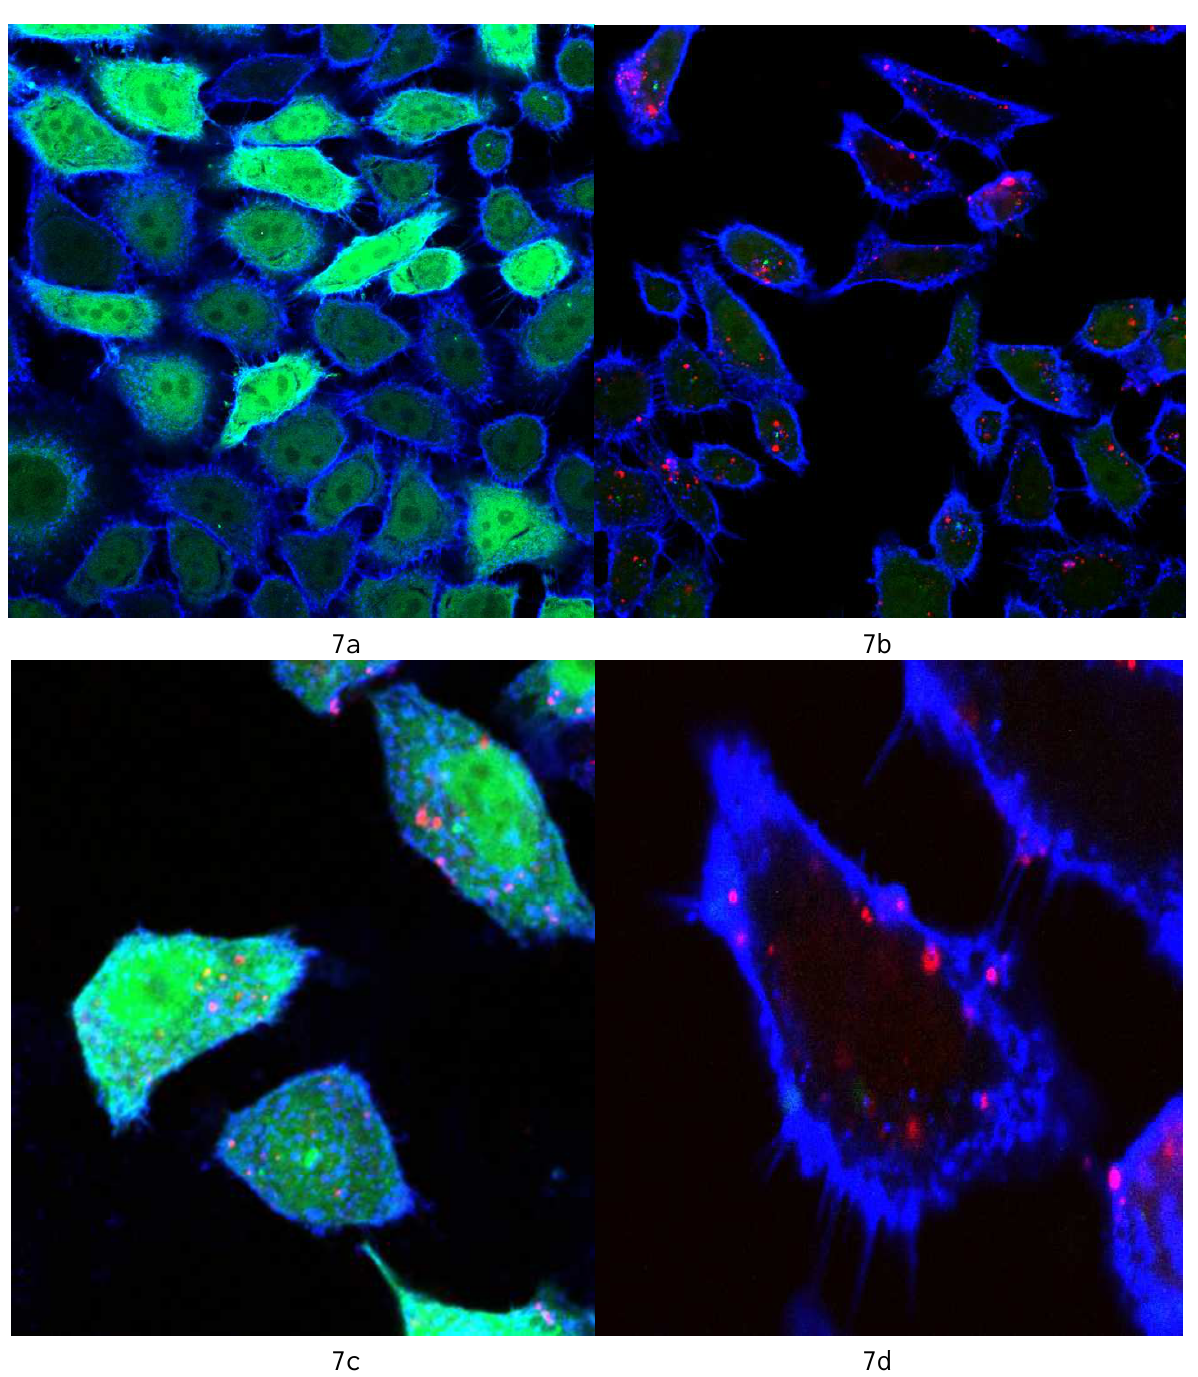
Figure 7. Confocal microscopy cell imaging. GFP fluorescence (green), cell membrane stained with WGA-Alexa Fluor ® 555 (blue), and Alexa Fluor ® 647 (red) represents tagged siRNA delivered with N 4 , N 9 -dioleoylspermine 4 . ( a ) non-transfected HeLa cells (control); ( b, d ) HeLa cells 48 h post transfection with siRNA against GFP; ( c ) HeLa cells transfected with AllStars negative control